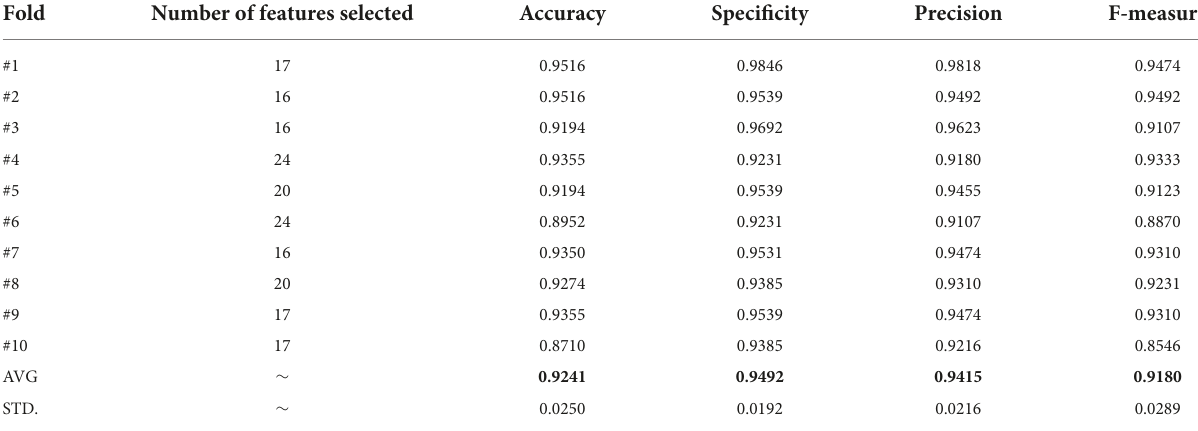
TABLE 20 Results of the bCOWOA-KELM model. Fold Number of features selected